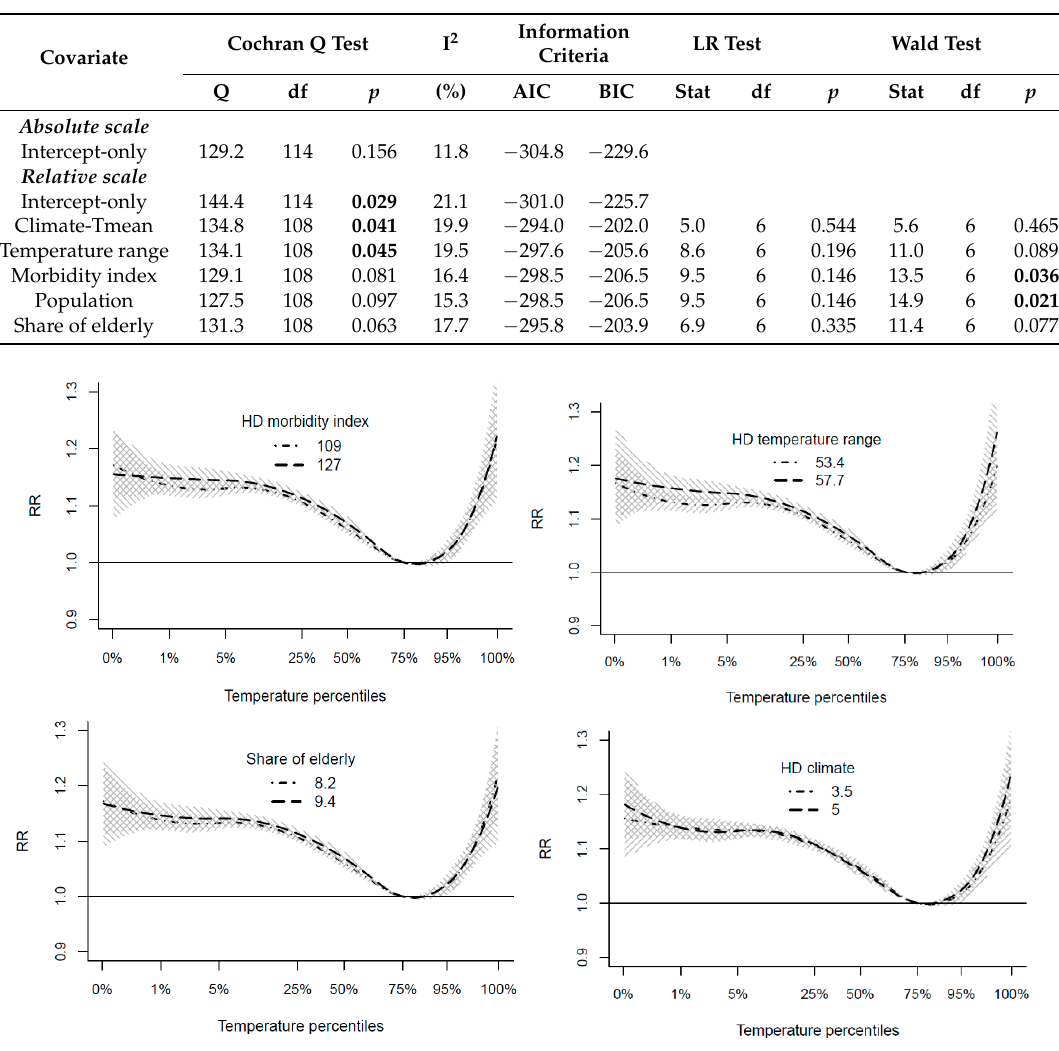
Figure 3. Meta-analysis of the temperature–mortality relationship on the relative temperature scale. Modelled relationships with the 25th and 75th percentiles of hospital district-level covariates: climatological mean temperature ( ◦ C), temperature range ( ◦ C), share of elderly (%), and morbidity index.